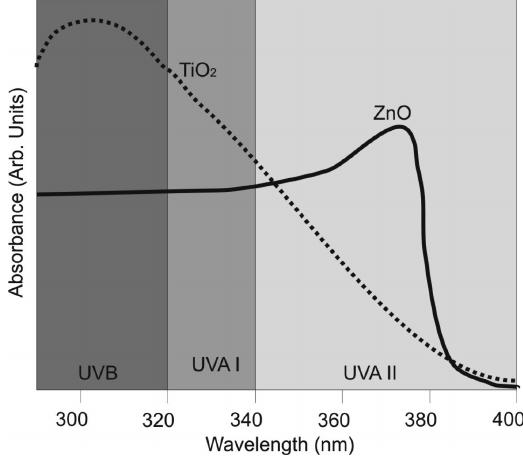
FIGURE 2 - Schematic demonstration of UVA and UVB absorbance by TiO and ZnO UV 2